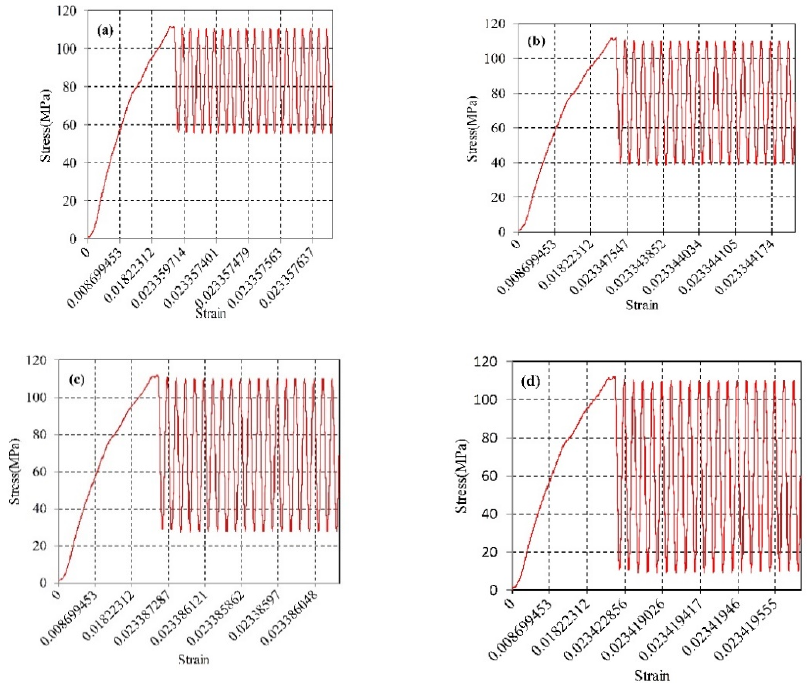
Figure 11. The simulation stress-strain curves under different amplitudes of the ultrasonic frequency 20 kHz: ( a ) Amplitude 4 µ m; ( b ) Amplitude 5.2 µ m; ( c ) Amplitude 6 µ m; and ( d ) Amplitude 7.3 µ m.